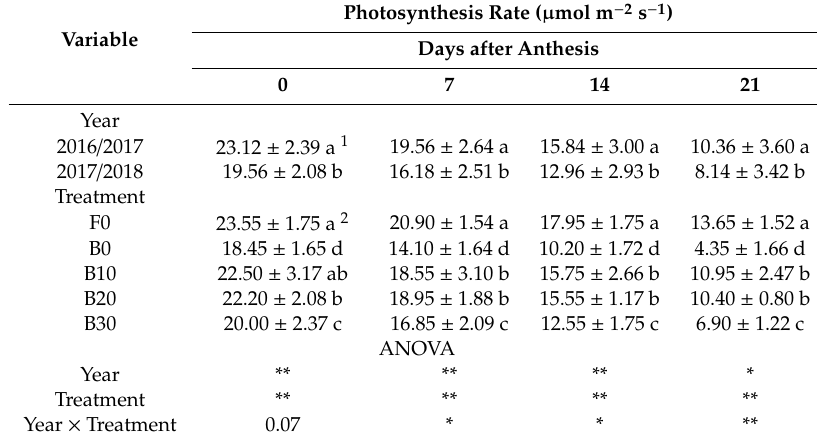
1 Values are means averaged across treatments. 2 Values are means averaged across years. Means followed by di ff erent letters within each column are significantly di ff erent at 0.05. *: Significant at the 0.05 probability level. **: Significant at the 0.01 probability level. F0: freshwater irrigation. B0, B10, B20, B30: saline water irrigation combined with biochar application of 0, 10, 20, 30 t ha − 1